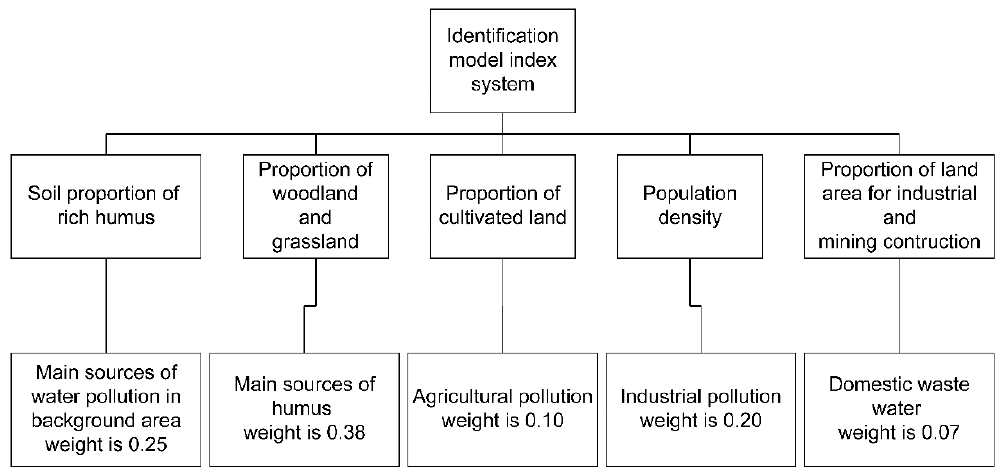
Figure 6. Selection of model indices and their relative weights.